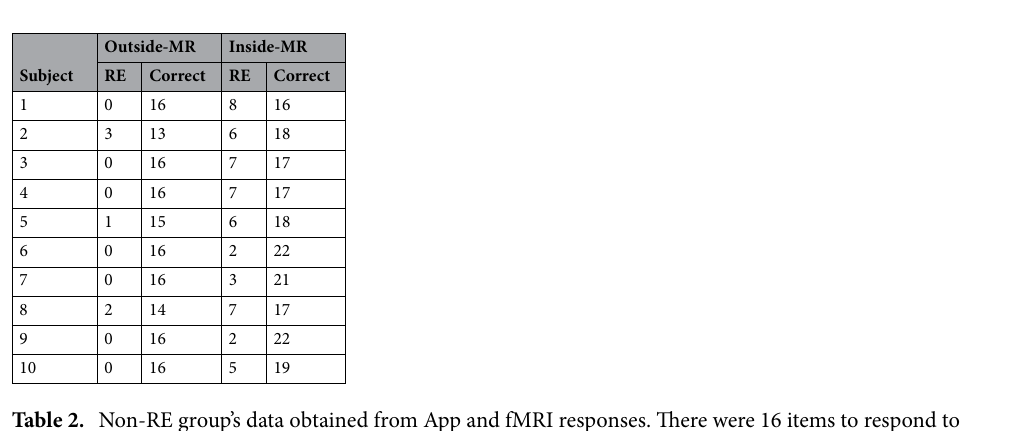
Table 2. Non-RE group’s data obtained from App and fMRI responses. There were 16 items to respond to outside-MR and 24 items